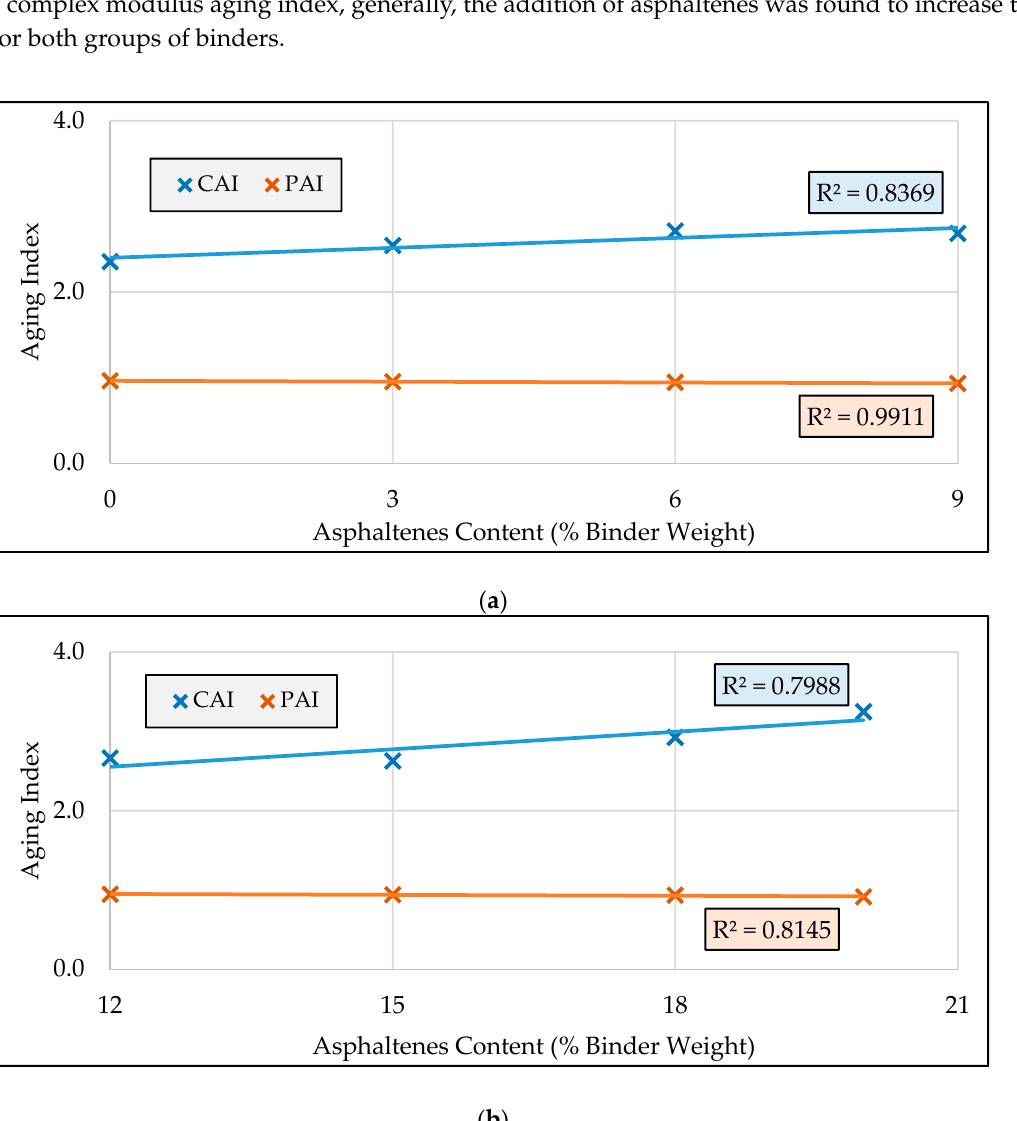
Figure 5. Aging indices for asphaltenes-modified binders: ( a ) aging indices of the first group of modified binders at 70 °C; ( b ) aging indices of the second group of modified binders at 82 °C.